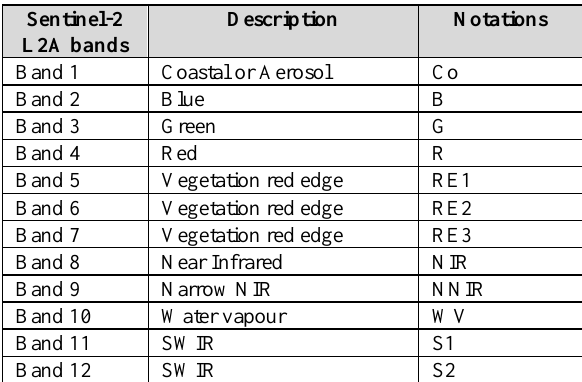
Table 3 . Sentinel-2 L2A bands